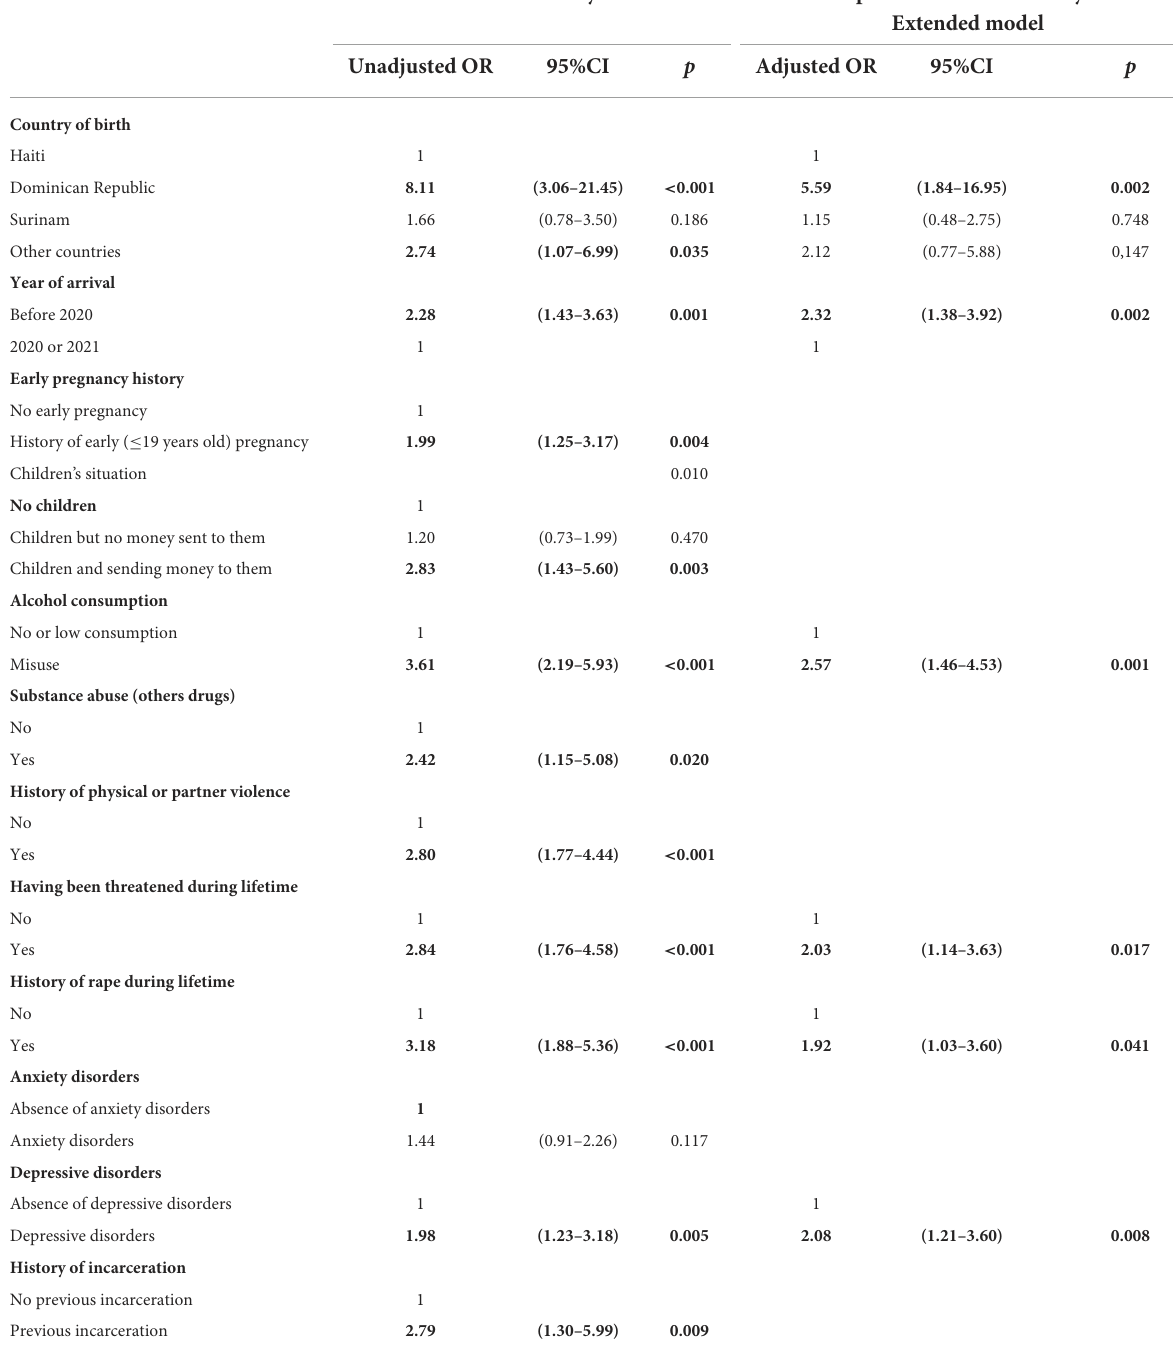
TABLE 4 Univariate and multivariate analyses of factors associated with transactional sex during lifetime among migrant women attending Red Cross HPCs in 2021, using stepwise logistic regression ( n = 382)—AUC = 0.77, the Hosmer and Lemeshow test, p = 0.118. Univariate